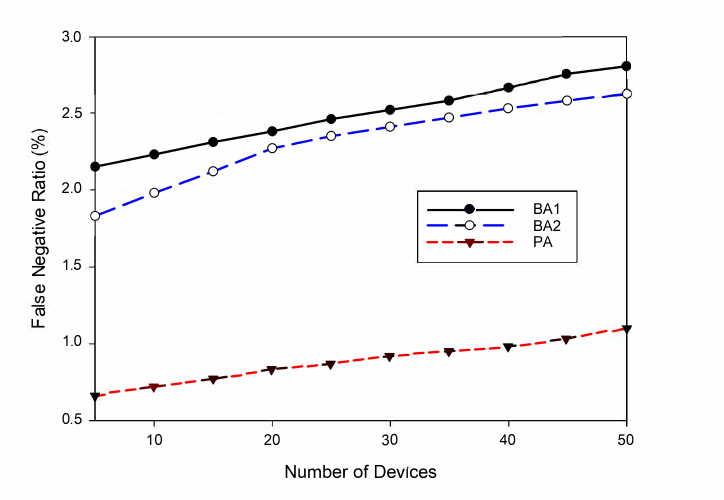
Figure 4. False negative ratio of the proposed approach compared to the baseline